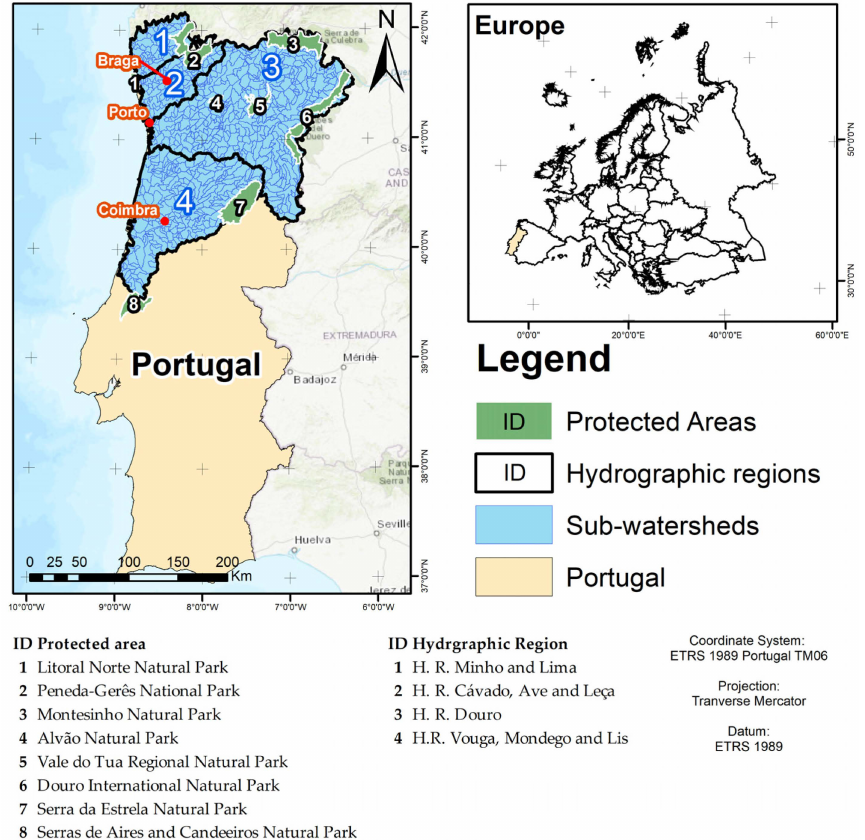
Figure 1. The location of the study area, including the delineation of hydrographic regions and protected